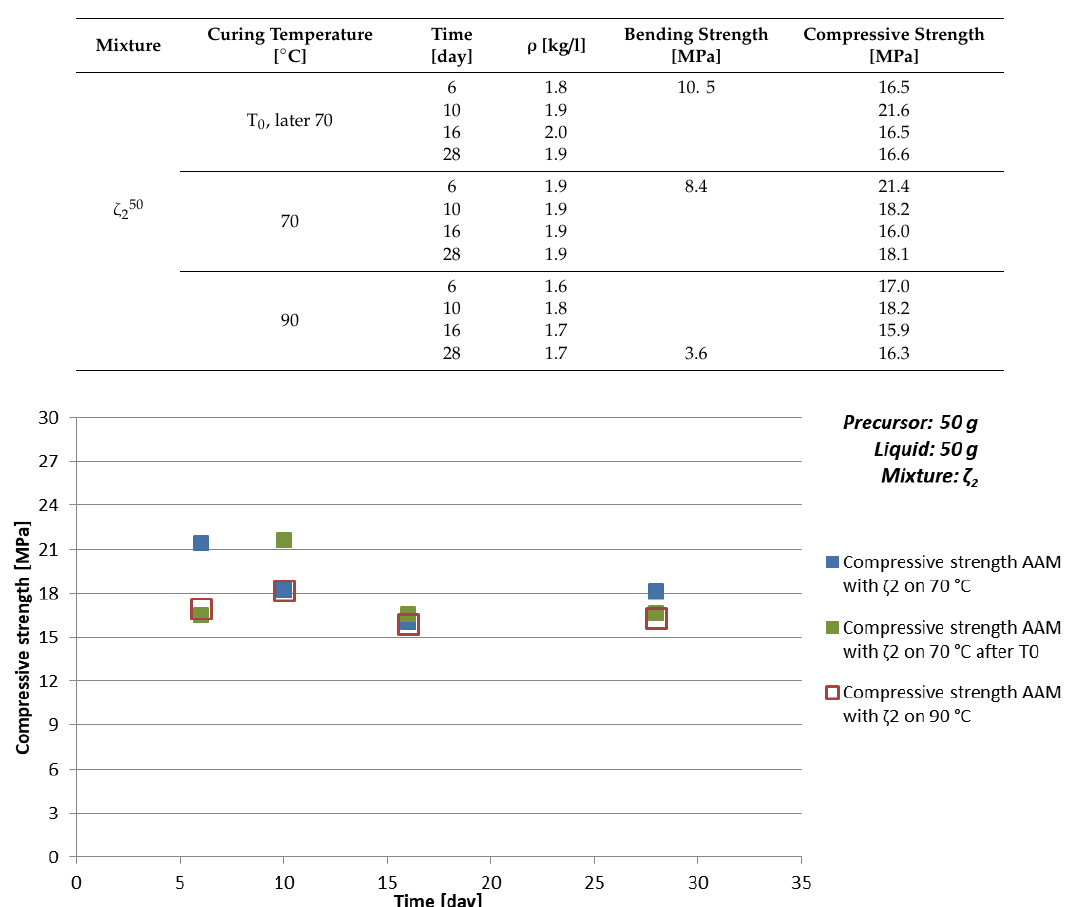
Figure 5. Time dependence of compressive strength of AAM prepared with mixture ζ 2 , cured on room temperature for 4 h and then on 70 °C for 20 h ( green ), cured on 70 °C for one day ( blue ), and cured on 90 °C for one day ( red ).